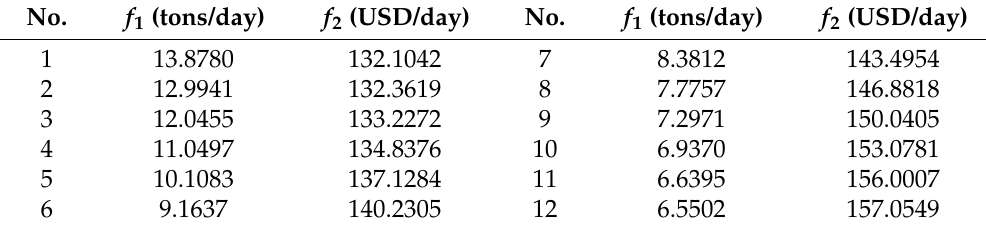
Table 3. List of solutions of the Pareto front of Figure 2.